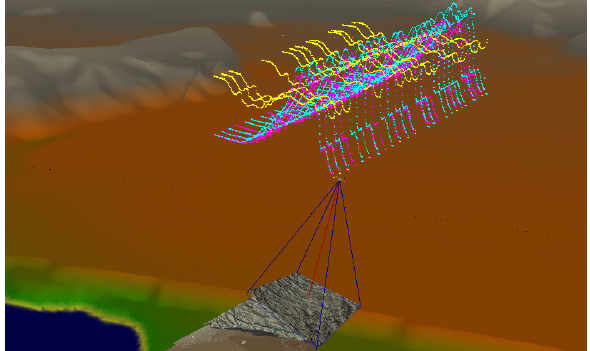
Figure 6: Spectrometer measurements from Ny- ˚ Alesund on Sval-